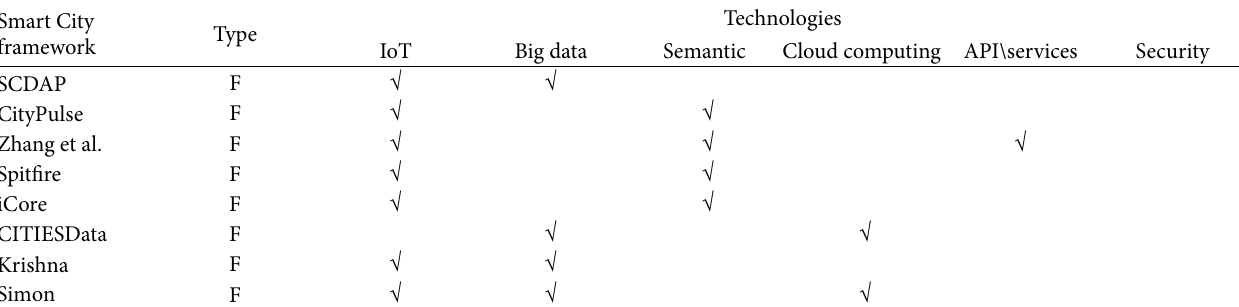
Figure 1: Smart City platforms technologies. Table 1: A comparative study among Smart City frameworks and its